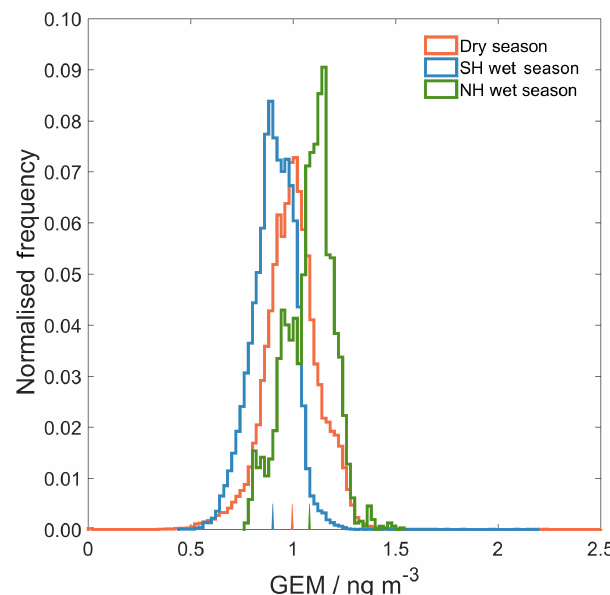
Figure 5. Normalised frequency for all 5min GEM data, split into dry season, SH wet season, and NH wet season. Vertical lines at bottom of figure indicate mean